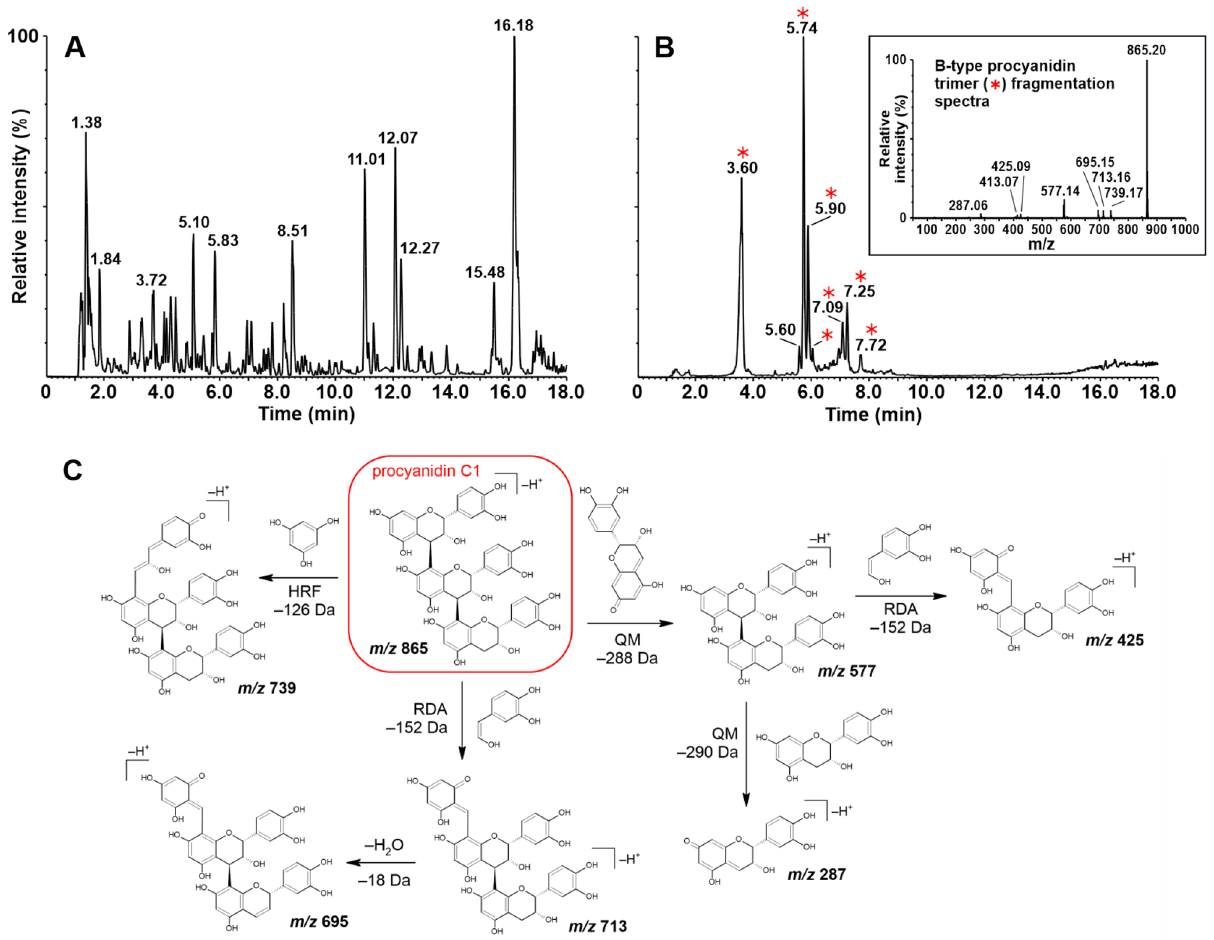
Figure 3. ( A ) UHPLC-ESI–MS base peak chromatogram of a crude Viola odorata root extract (160 mg DW/ mL) recorded in negative ion mode. ( B ) Extracted ion chromatogram recorded in negative ion mode ( m/z 865). Analytes showing fragmentation patterns characteristic of B-type procyanidin trimers are indicated by red asterisks. Inset: B-type procyanidin trimer fragmentation spectrum obtained in negative ion mode with a collision energy of 20 eV. ( C ) B-type procyanidin trimer fragmentation pathways of procyanidin C1 57 ;